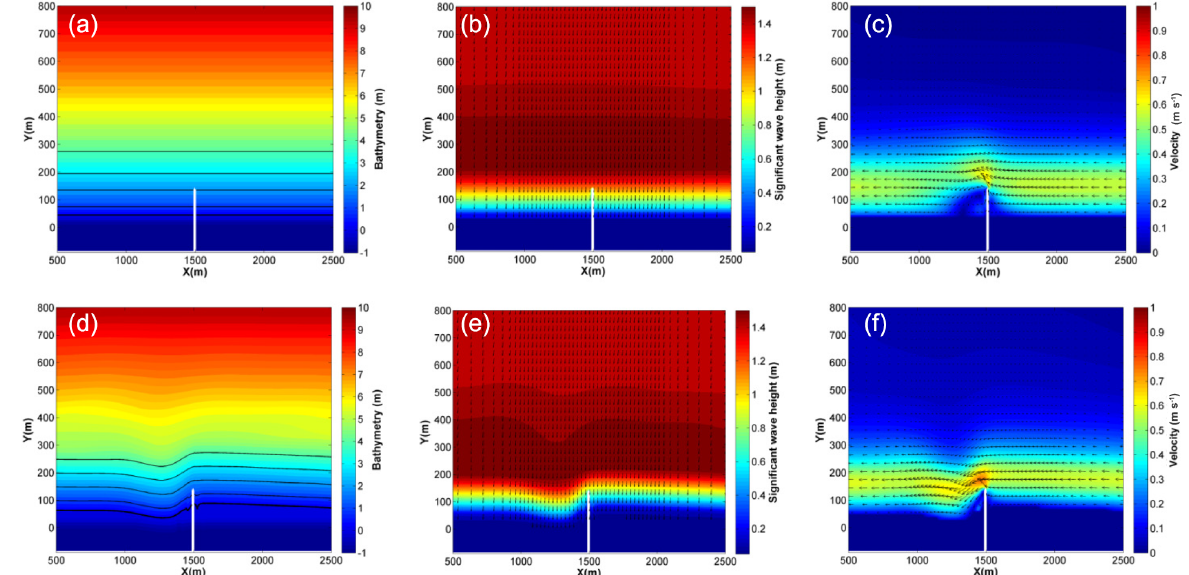
Figure 6. Groyne with a length of 100m from the shoreline. Bathymetry (a, d) , waves (b, e) , and currents (c, f) for the initial condition (a, b, c) and near equilibrium (d, e, f) after 9 years. The thicker isoline in the bathymetry represents the shoreline, whereas the others represent the 1, 2, 3, and 4m isobaths.